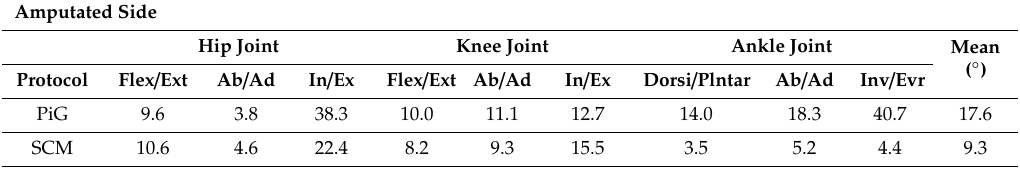
Table 10. Between-subject variability illustrated by the mean standard deviation over the amputee gait cycle among the seven participants for both protocols.